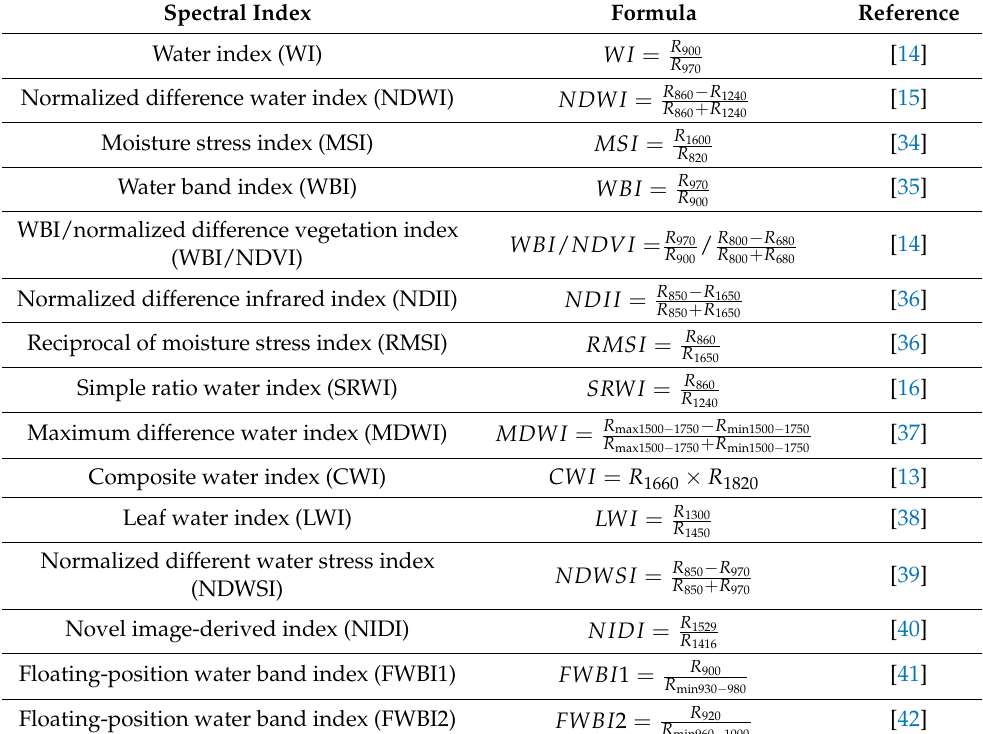
Table 1. Published spectral indices used in this